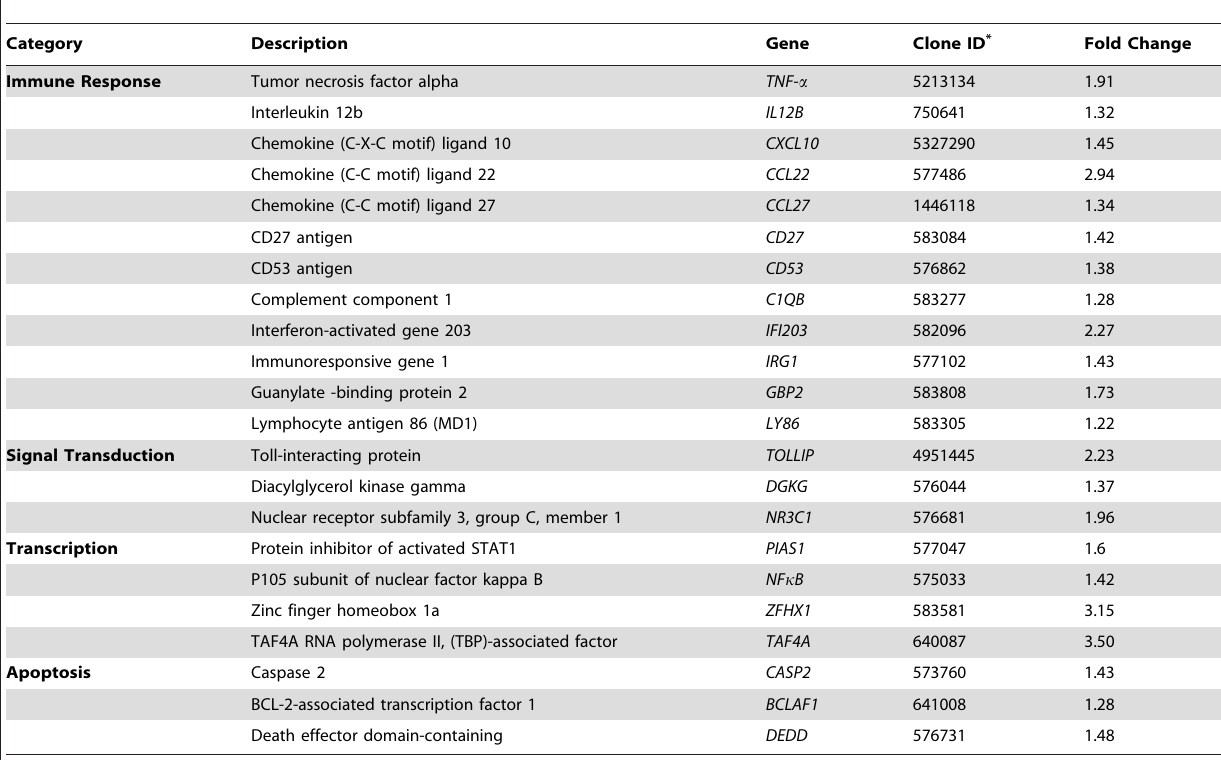
Table 1. Selected genes up-regulated in murine dendritic cells after 6 h of infection with P. brasiliensis .